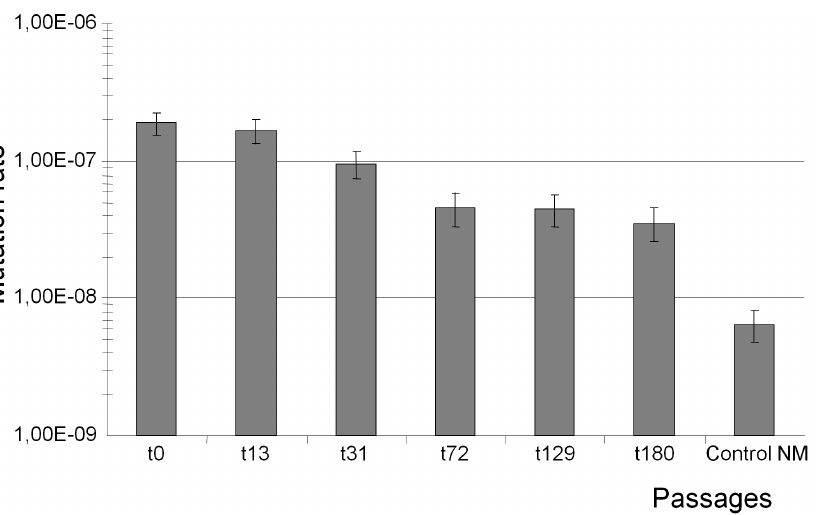
Figure 4. Mutation rates of cultures along the long-term sequential passages experiment. In the y axis, mutation rates (Luria-Delbru¨ck method) in the x axis, numbers of the serial passages in which mutation rates were determined. Bars reflect the corresponding ranges. The last column on the right side is the mutation rate of the original mutator strain after complementation with the wild-type mutS gene, serving as a control for non-mutator mutation rate.